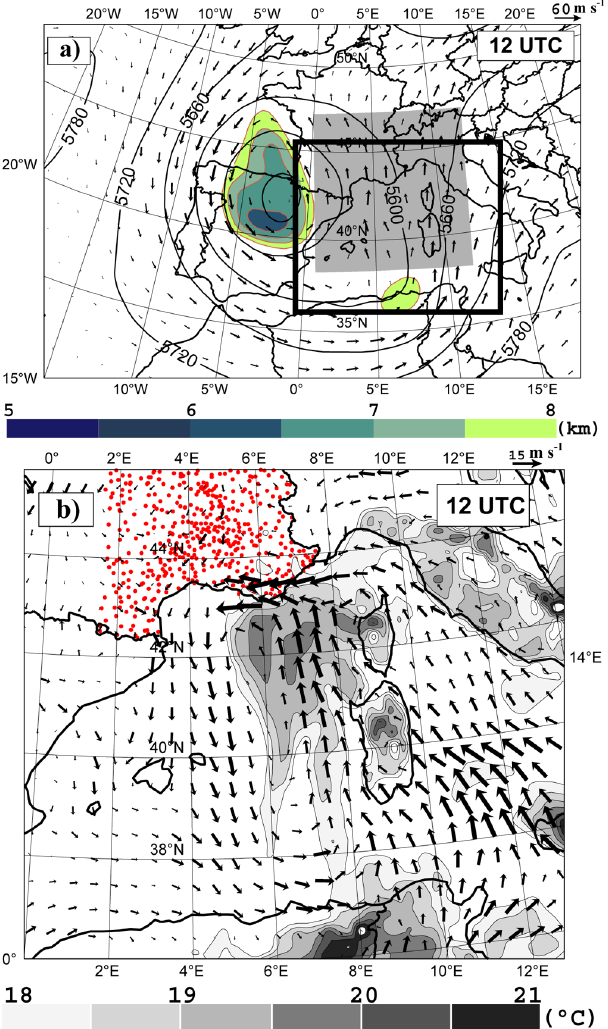
Fig. 1. Var case (a) : 300hPa winds (arrows), 1.5PVU surface height (colour) and 500hPa geopotential height (solid line) and (b) : adia- batic wet-bulb potential temperature (shading) and horizontal winds at 925hPa, from ARPEGE analysis on 15 June 2010 at 12:00UTC. The computational domain (shading) used for AROME ensemble simulations is shown in (a) . The black rectangle represents the do- main seen in (b)